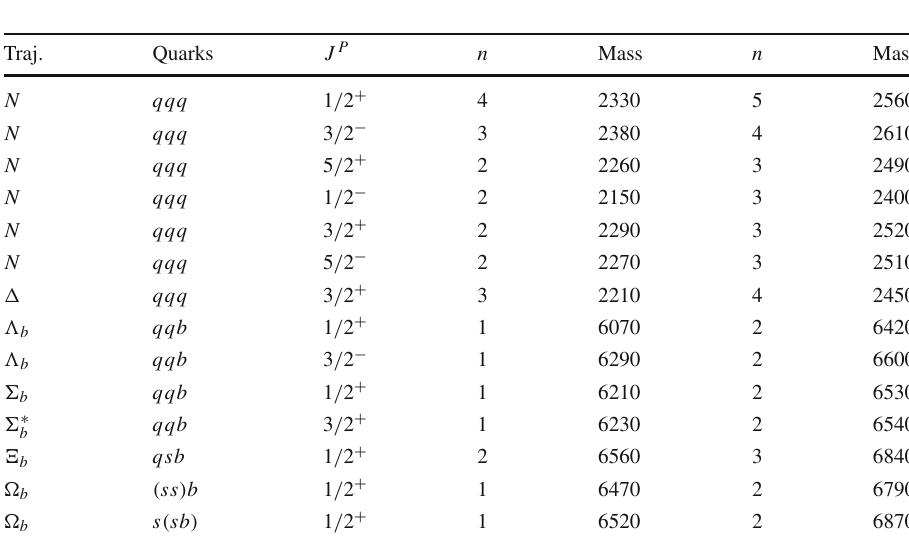
baryon next states in the ( n , M 2 ) plane. The light